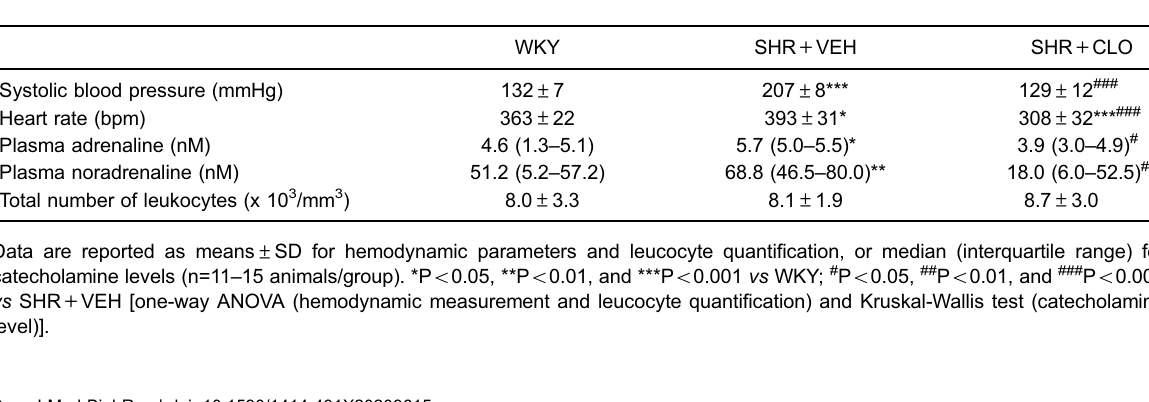
Table 1. Systolic blood pressure, heart rate, plasma catecholamines, and total blood leukocyte quanti fi cation in normotensive animals (WKY) and spontaneously hypertensive rats (SHR) treated with vehicle (SHR + VEH) and hypertensive animals treated with clonidine (SHR +